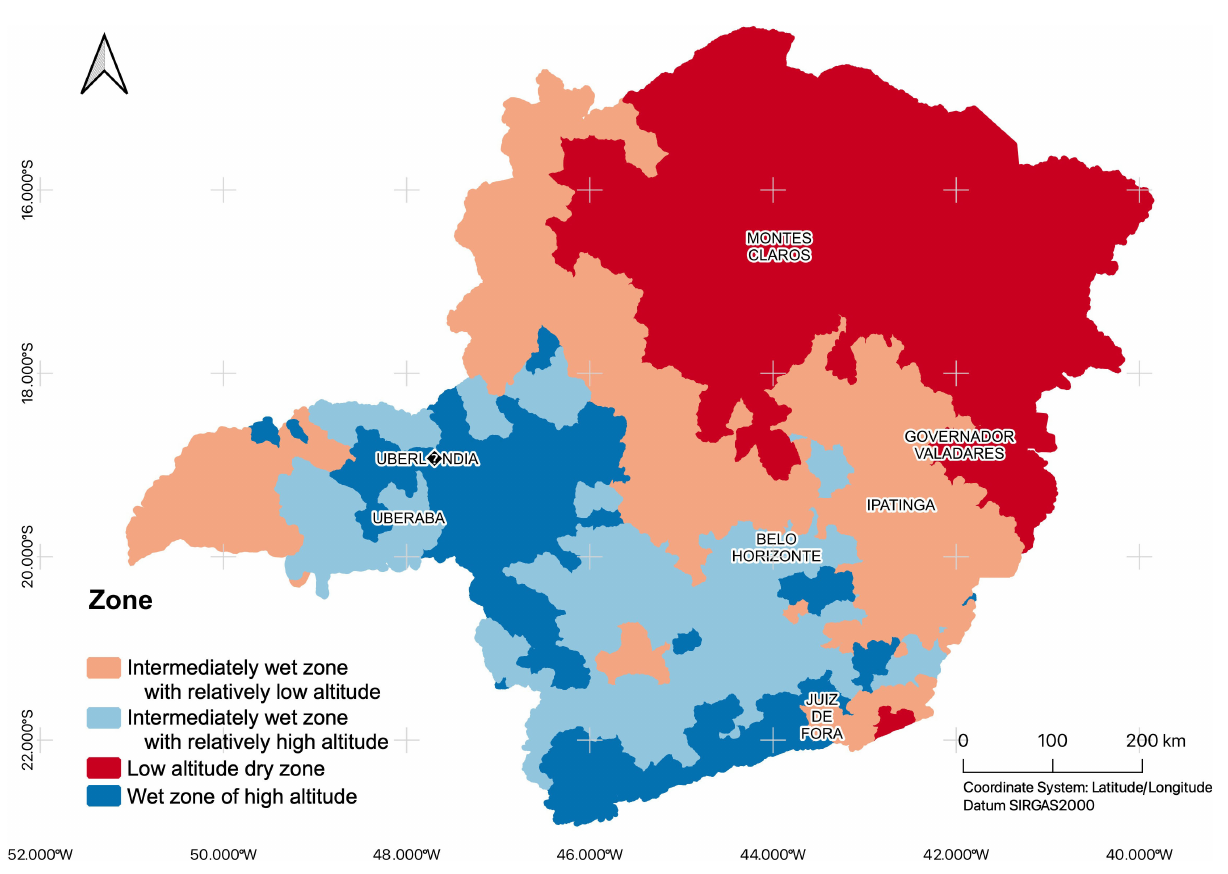
FIGURE2 Altitude-adjusted homoclimatic zones for extreme precipitation events in Minas Gerais, Brazil. Source: Anderson et al. (2013), Instituto Brasileiro de Geografia e Estatística – IBGE (2020), and The Climdex Project—Xavier et al. (2015).